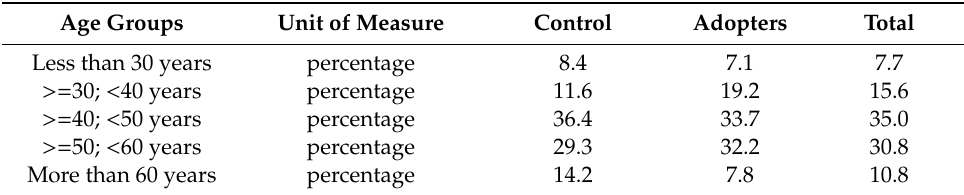
Table 2. Number of farmers by age